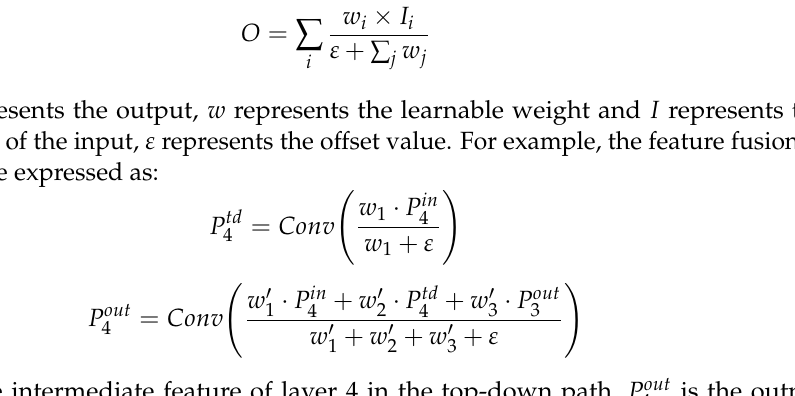
Figure 5. The structure of R-FPN. R-FPN, by adding an extra weight for each input, makes the network learn the im- portance of each input characteristic in the process of training and makes the information in the network make full use of each input characteristic. It also solves the problem that the resolution and receptive field cannot, achieves the best results at the same time in the process of feature extraction and enhances model learning ability, so as to improve the accuracy of small object detection. 3. CSMA Attention Module It has become an important means to improve the performance of deep neural net- works by adding attention mechanism to neural networks, which can accurately focus on all relevant elements input by the outside world [14]. There are two kinds of attention mechanisms widely used in computer vision research: spatial attention and channel at- tention. Channel attention focuses on “what” is the meaningful input image, while spatial attention focuses on “where” the most informative part is. Spatial attention is a supple- ment to channel attention [15]. Spatial attention and channel attention complement each other to improve feature extraction performance. Although fusing them together may yield better results than they would individually, this inevitably increases computational overhead. In this paper, we propose a CSMA attention module to solve this problem that uses a hybrid unit to effectively combine the two types of attention mechanisms. For a given input feature map C H W X